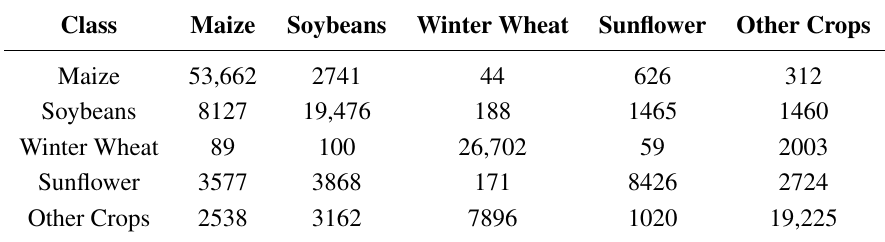
Figure 7. F-score and OA results for RF and SVM for the Ukraine test site. ( a ) RF; ( b ) SVM. Table 5. Confusion matrix for RF on the Ukraine test site.